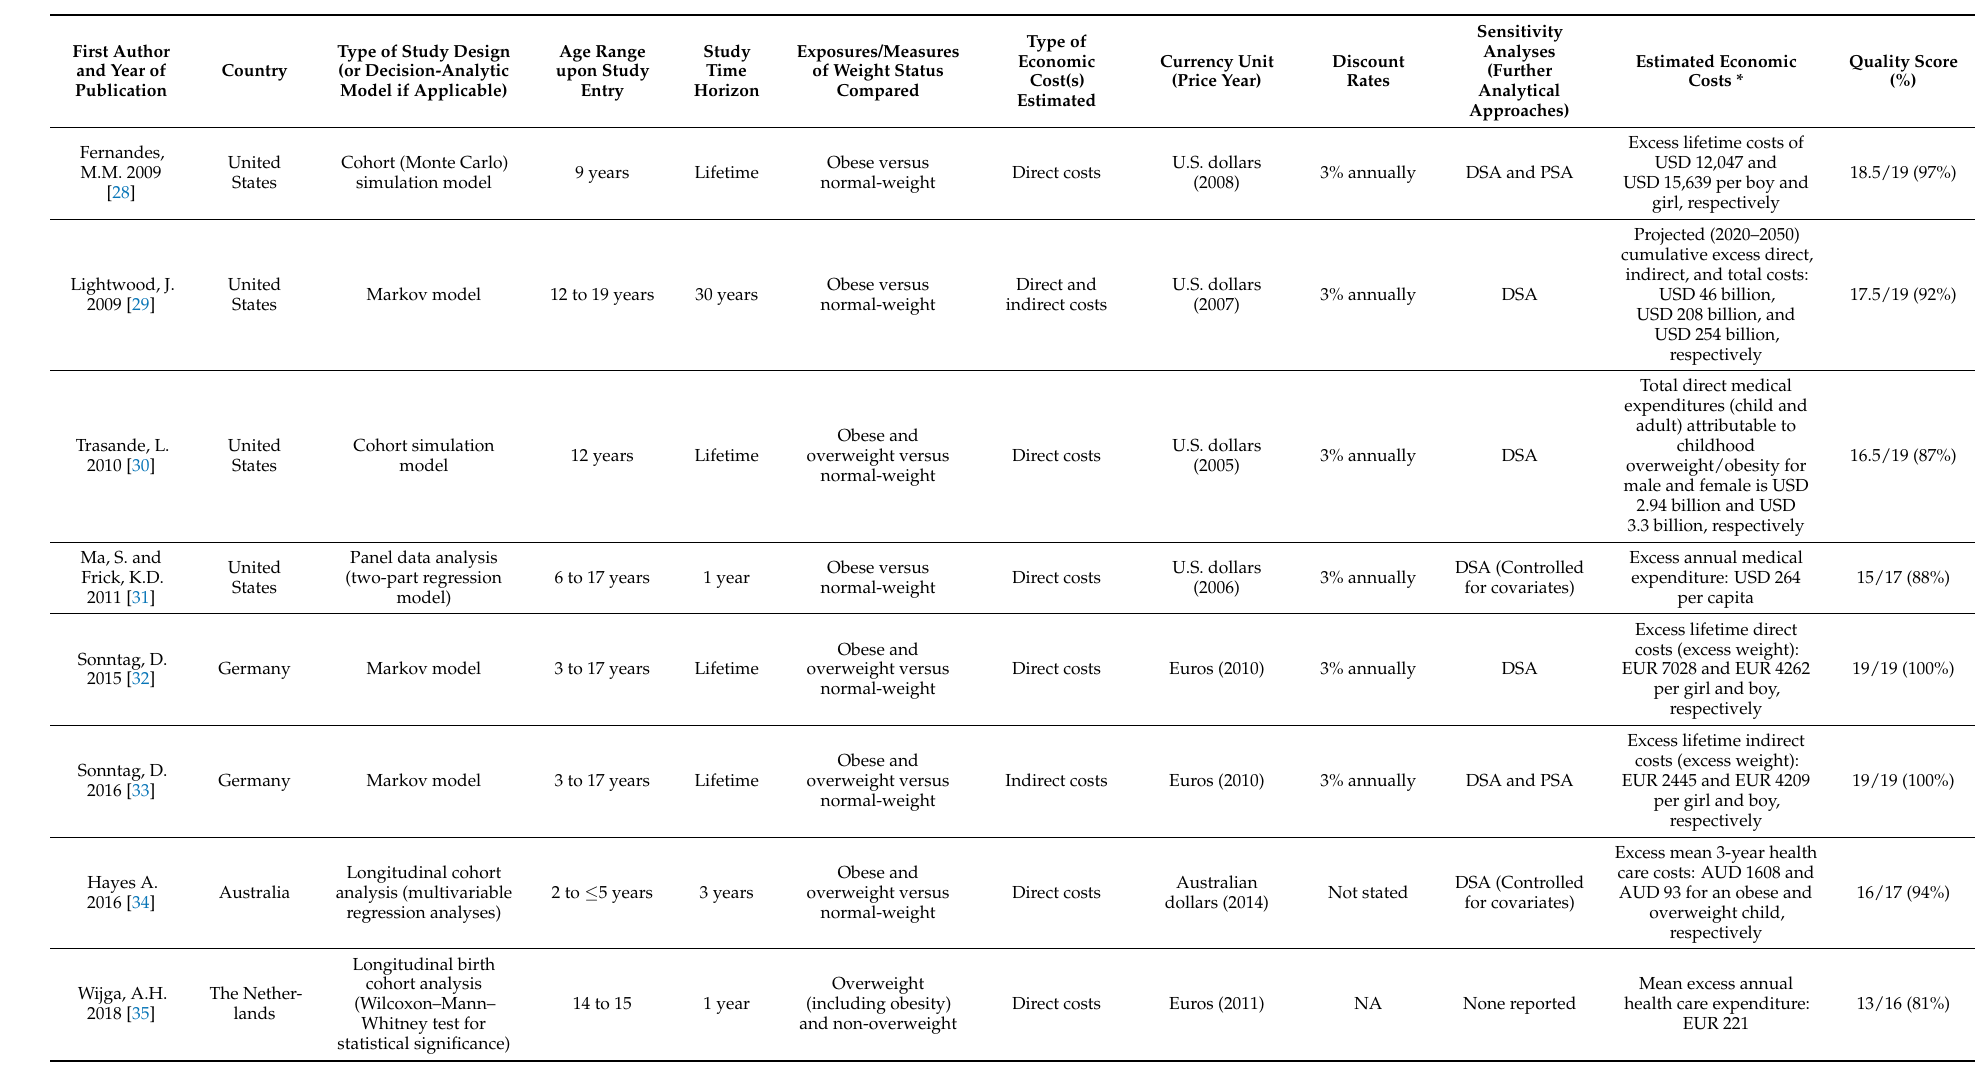
Table 2. Descriptive analysis of the key assessment items for individual economic cost